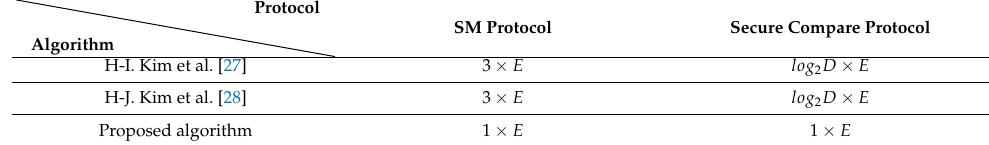
Table 5. Comparison of the number of encryption according to encrypted random value